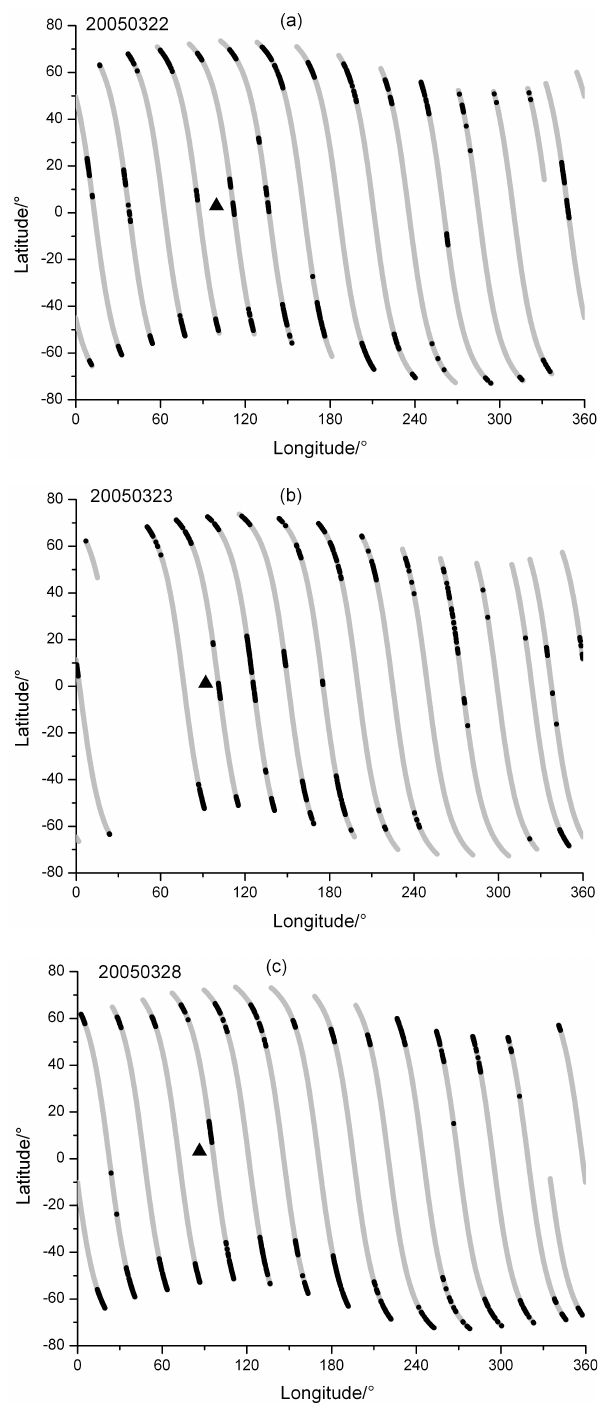
Fig. 4. The spatial distribution of electrostatic perturbations (dark points) on 22, 23 and 28 March before a 8.6 earthquake at Suma- tra Indonesia on 28 March 2005 (the triangle in the figure is the